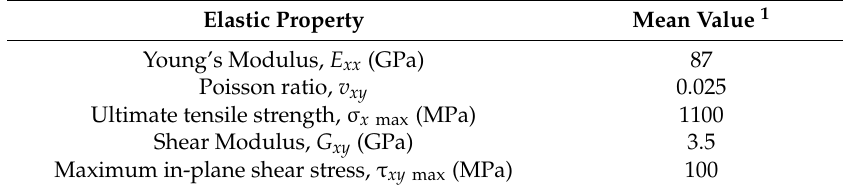
Table 6. Mechanical properties of IM7 Biax/EPOLAM 2019 CFRP used in aileron main